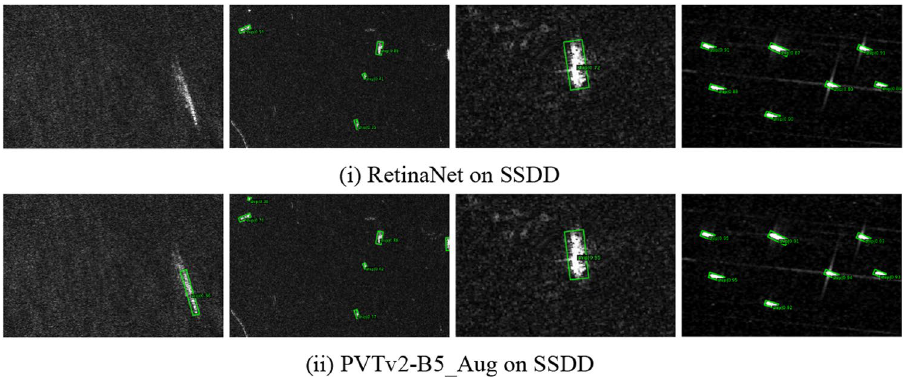
Fig. 11 Effectiveness of PVTv2-B5_Aug on SSDD